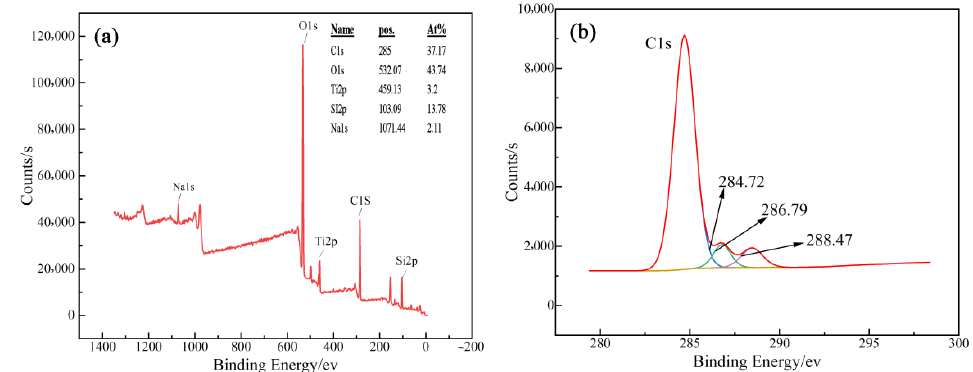
Figure 7. XPS analysis of MAO coating on S4 ( a ) XPS spectra of MAO coating, ( b ) XPS high resolution spectra of C detected.